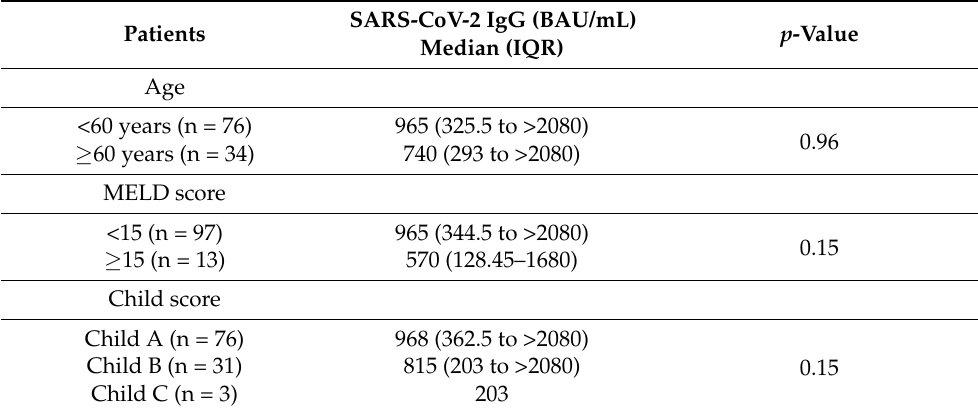
Table 3. Comparison of the antibody response in different groups of patients with liver cirrhosis. Patients grouped by age, MELD score, and class of Child–Pugh